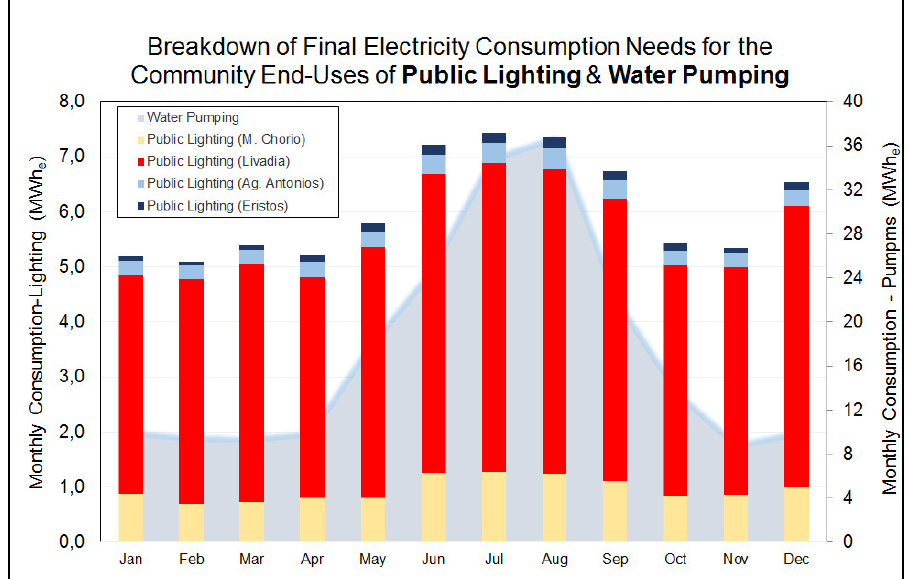
Figure 8. Public lighting-water pumping electricity consumption breakdown.